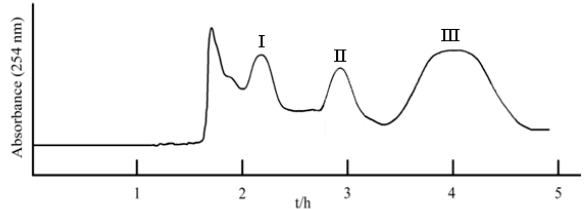
Figure 3. HSCCC chromatogram of the crude sample of B. simaoensis . Solvent system: n -Hexane-ethyl acetate-methanol-water (1:2:1:2, v / v ); revolution speed: 850 r/min; flow rate: 2.0 mL/min; sample size: 210 mg; UV detection wavelength: 254 nm.